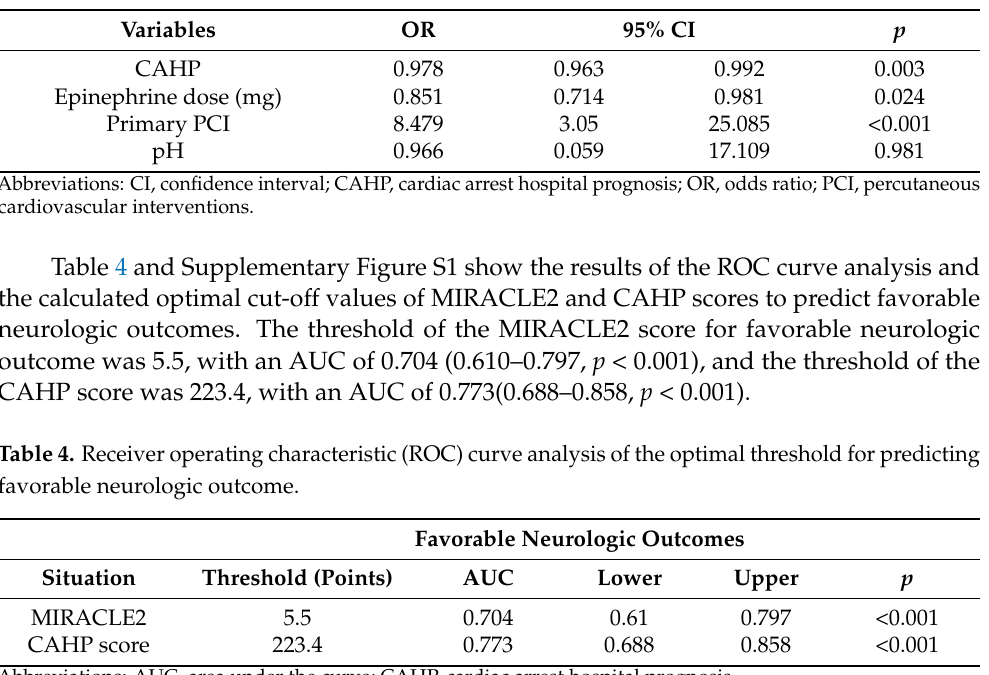
Table 3. Adjusted odds ratios of CAHP score for favorable neurologic outcome.